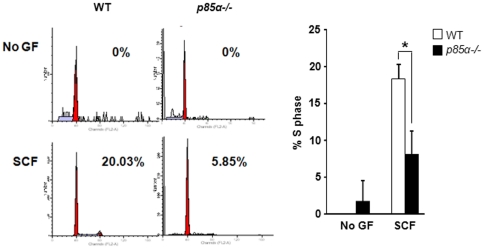
Reduced cycling of p85α-deficient BMMCs.BMMCs from WT and p85α−/− mice were starved for 6 hours in serum- and cytokine-free media and cultured in the presence or absence of SCF (50 ng/mL). After 48 hours, cells were stained with propidium iodide followed by flow cytometry analysis as described in methods. Shown is a representative histogram (Left panel) and bar graph (Right panel) demonstrating the percentage of cells in S phase in the presence or absence of SCF. Similar results were observed in two independent experiments. *p<0.05, WT vs. p85α−/−.